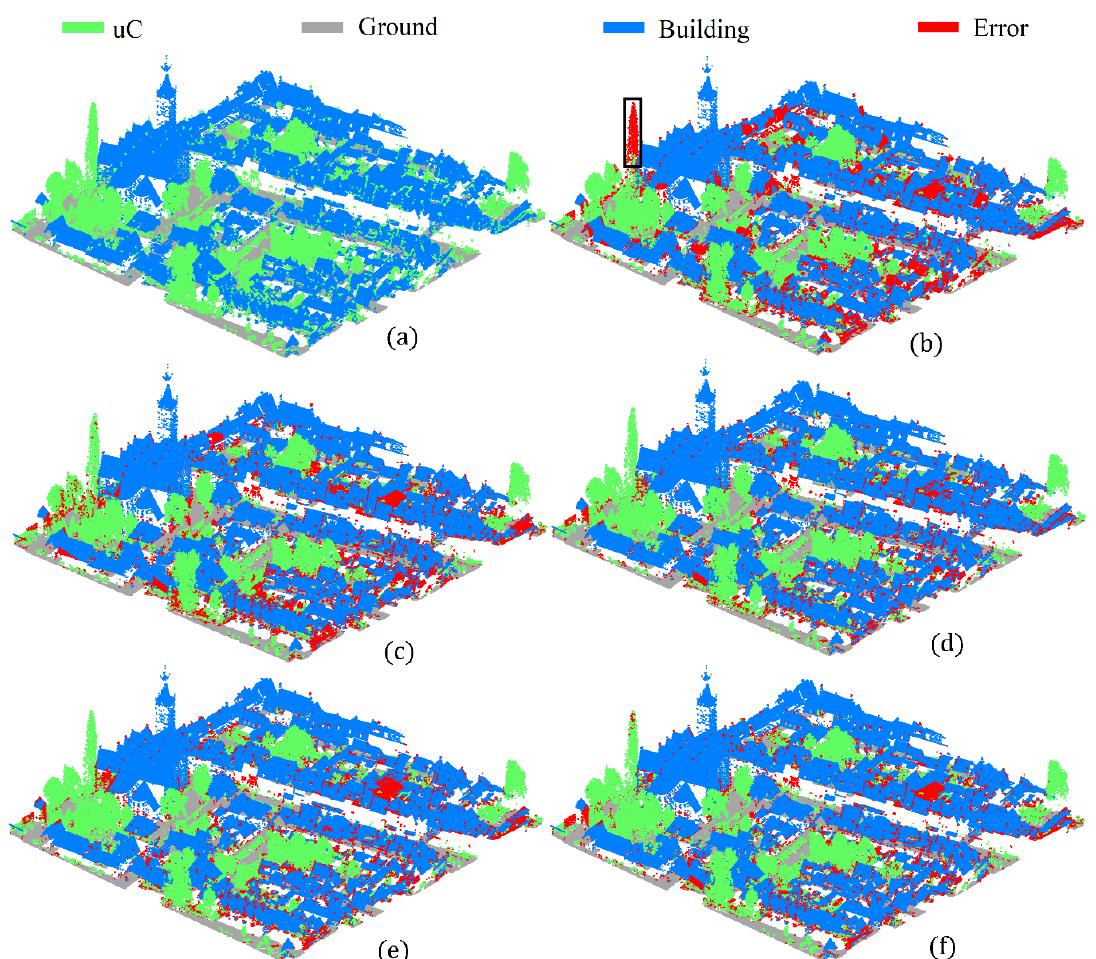
Figure 4: AHN test data set, (a) ground-truth, classification results for the inputs (b) Group 1, (c) Group 2, (d) Group 3, (e) Group 4, and (f) Group 7.